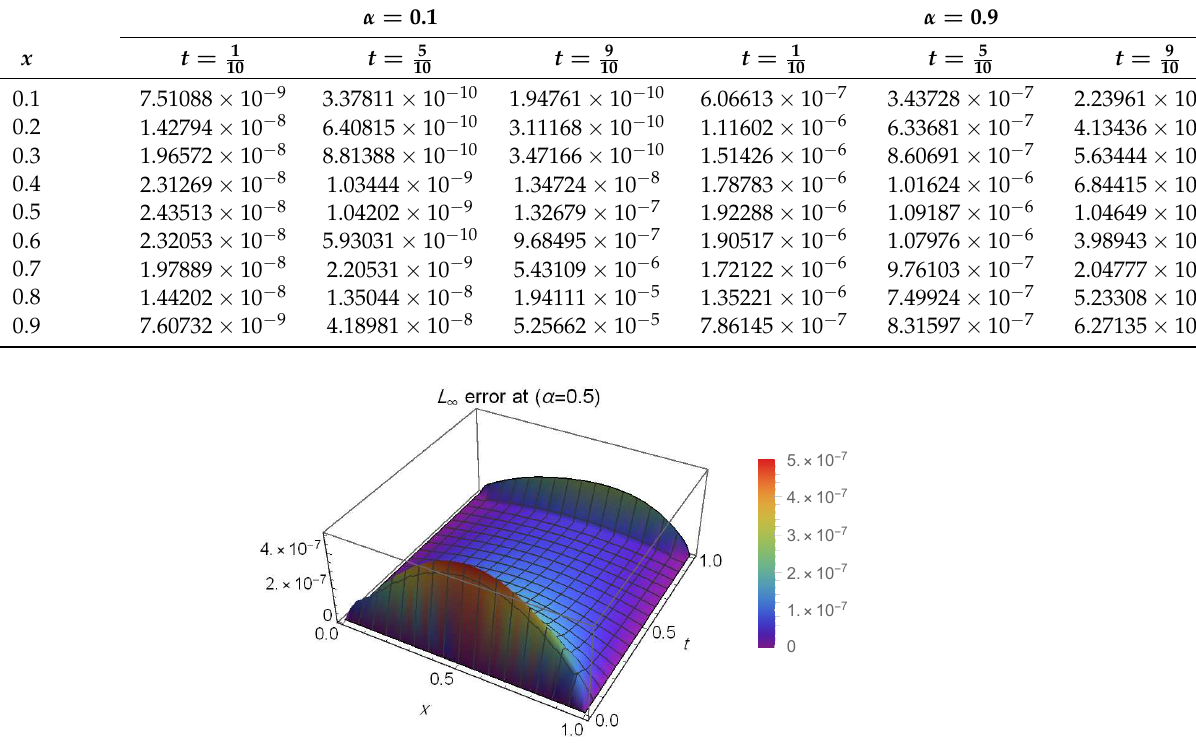
Table 5. The absolute errors for Example 3.